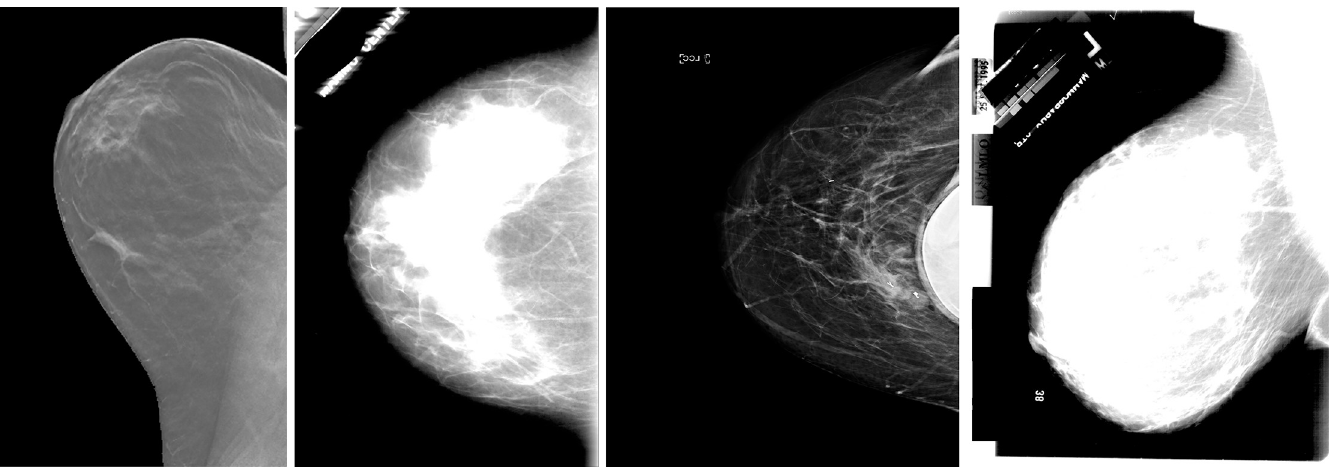
Fig 2. (a) Asymmetry (b) Calcifications (c) Carcinoma (d)